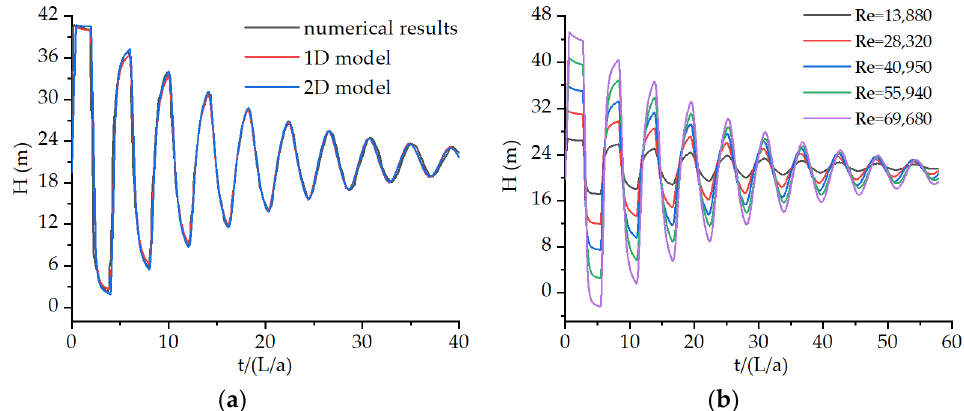
Figure 2. Variation in pressure head with time: ( a ) results of experiment and two simulations at Re = 55,940; ( b ) simulation results at different Re values.